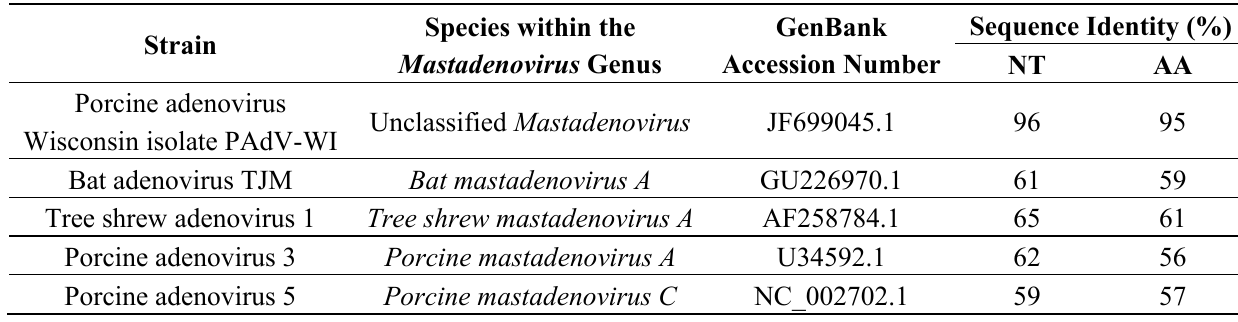
Table 1. Nucleotide (NT) and deduced amino acid (AA) sequence identities of the hexon gene fragment (599–725 bp) between Slovenian isolate porcine adenovirus (PAdV)-SVN1 and the most identical strains from